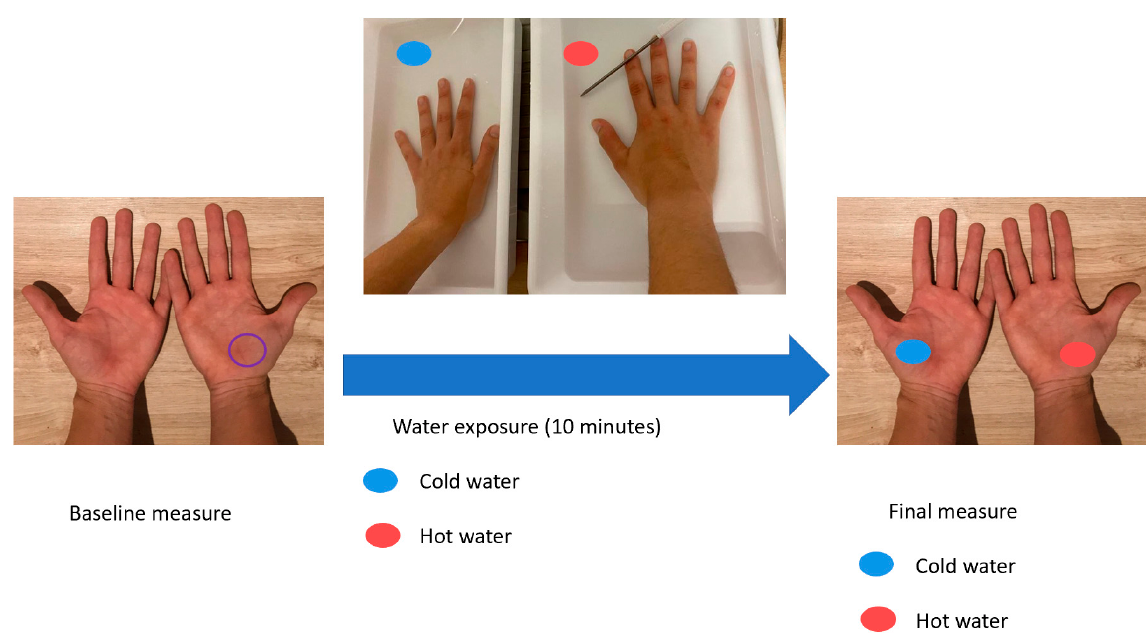
Figure 1. Flow chart of the measurements taken before and after water exposure.